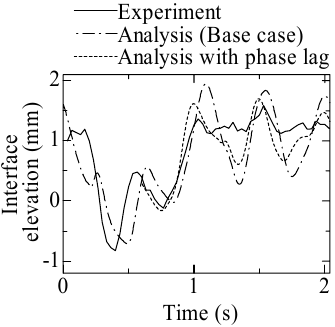
Fig. 9 Deviation of center-of-interface elevation from the cross-sectionally averaged water